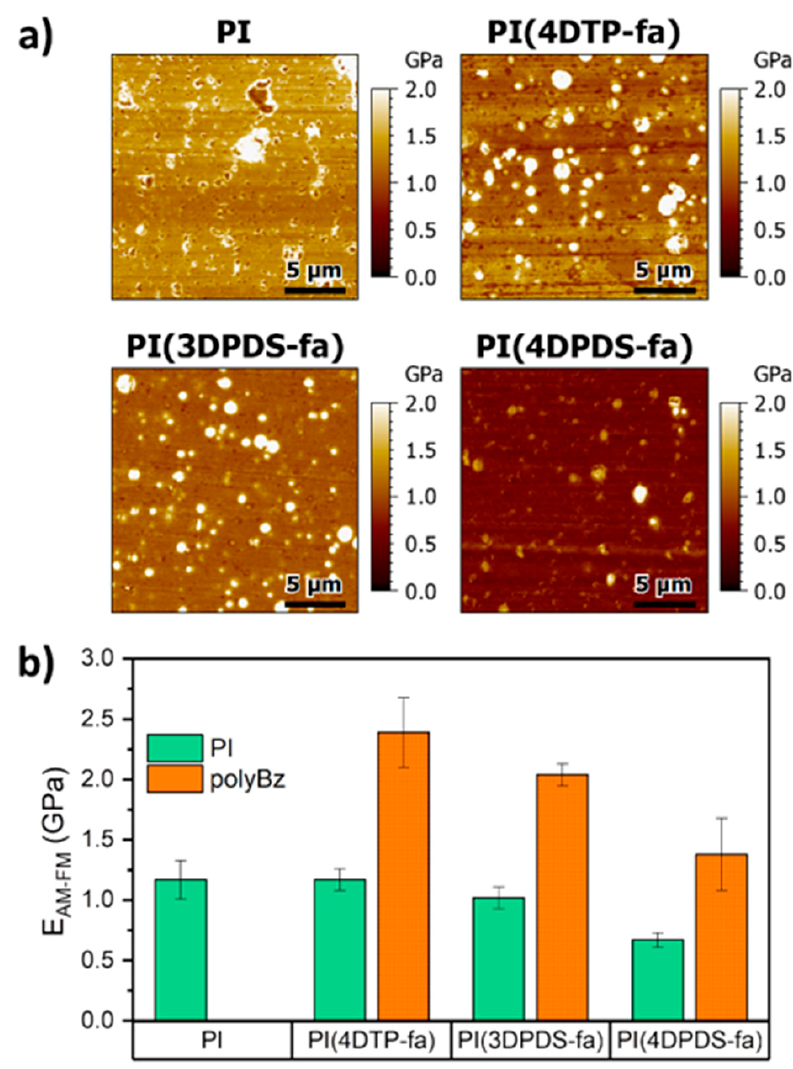
Figure 6. ( a ) AFM-AM-FM images of the modulus of rubber compounds without and with 15 phr of polyBz, ( b ) Measurements of the moduli in each of the phases in the compounds.